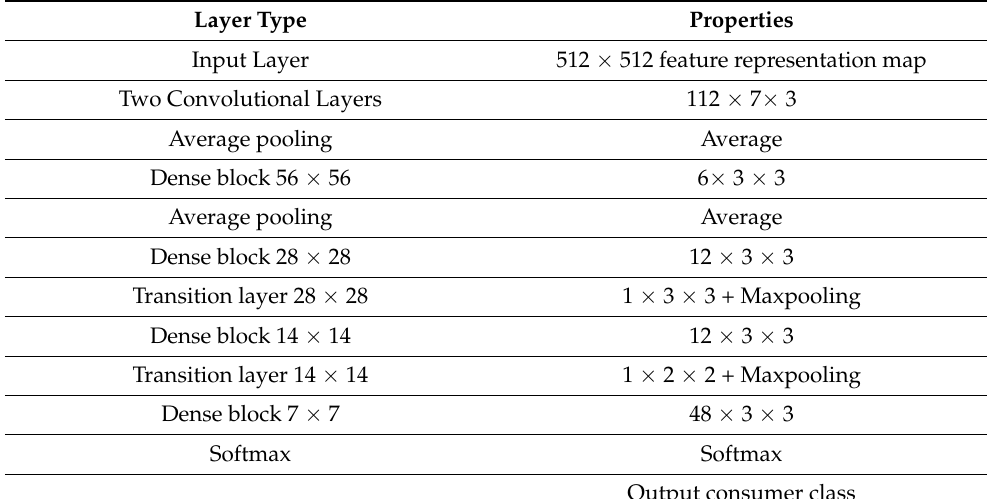
Table 2. The description of